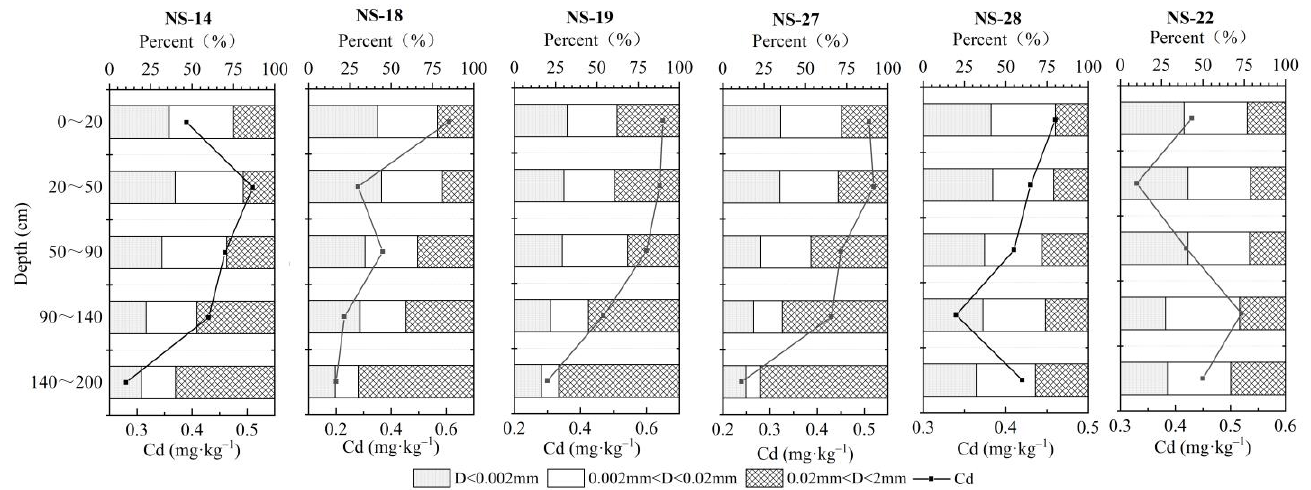
Figure 10. Changes in soil mechanical composition and cadmium content with depth in the deep profile soil (0–200 cm). profile soil (0–200